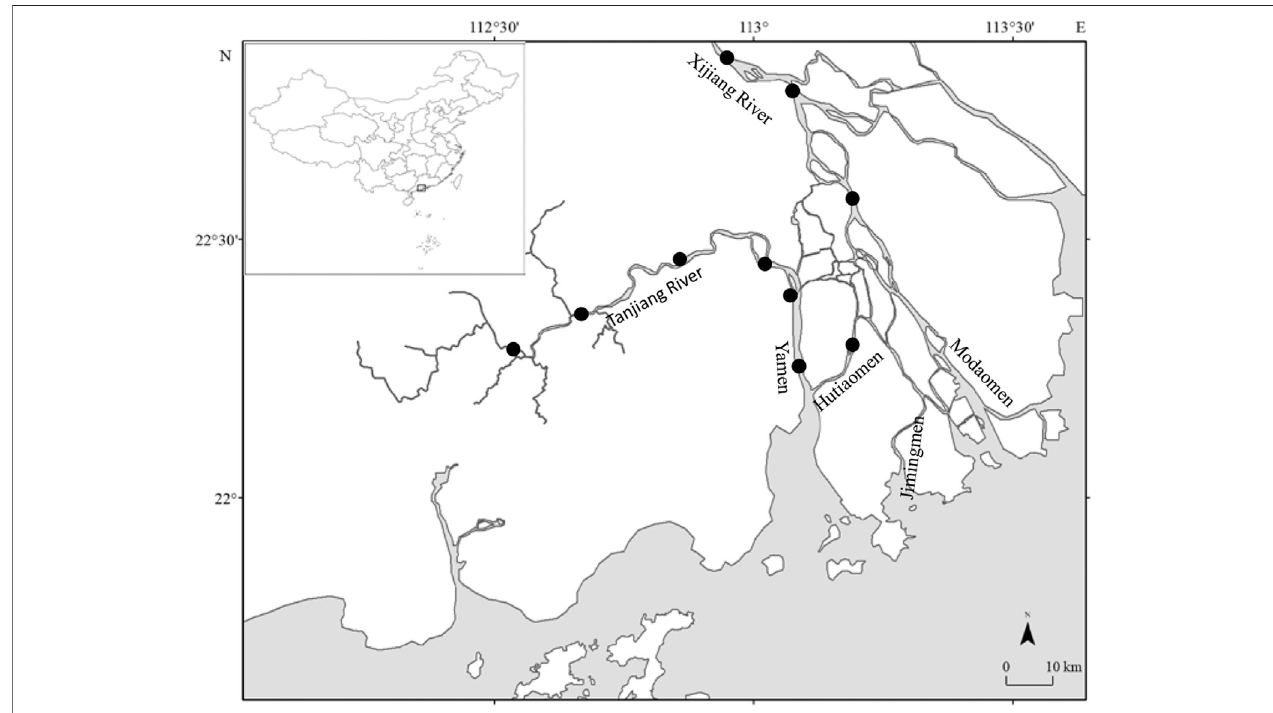
FIGURE 1 | Sampling locations of S. curriculus in the western Pearl River estuary. Black dots represent sampled sites.